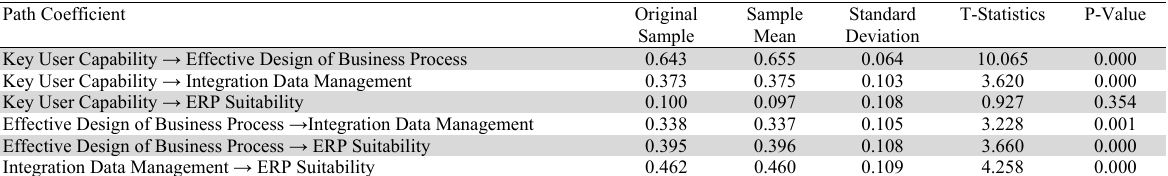
Path Coefficient Direct Effect